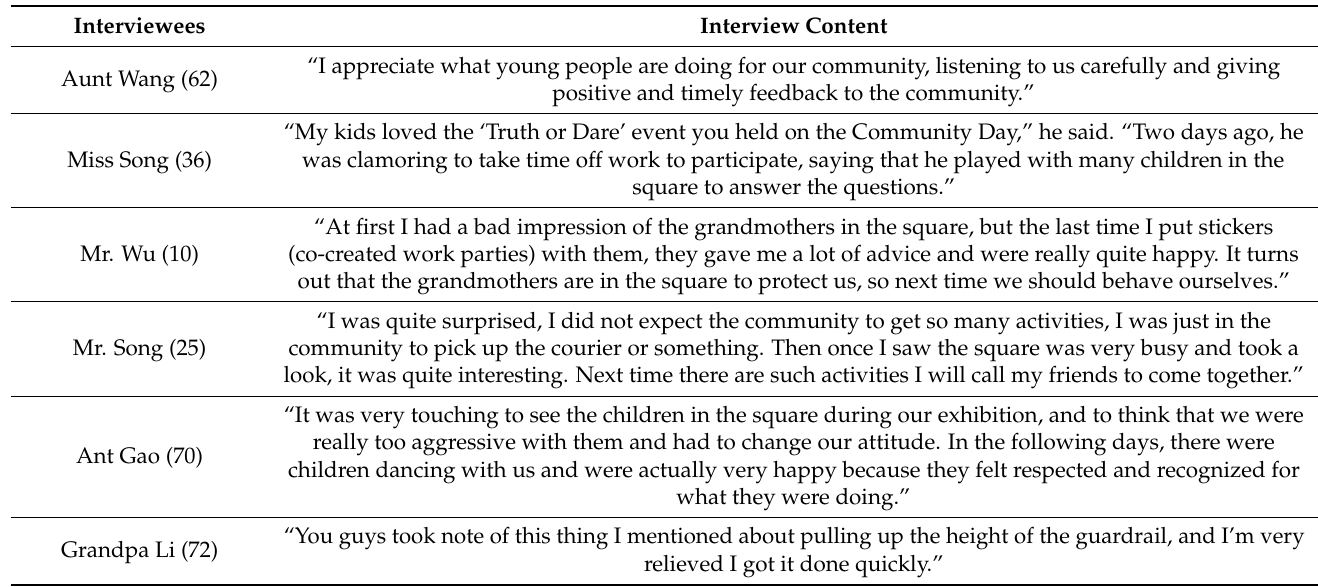
Table 2. Community participant interview